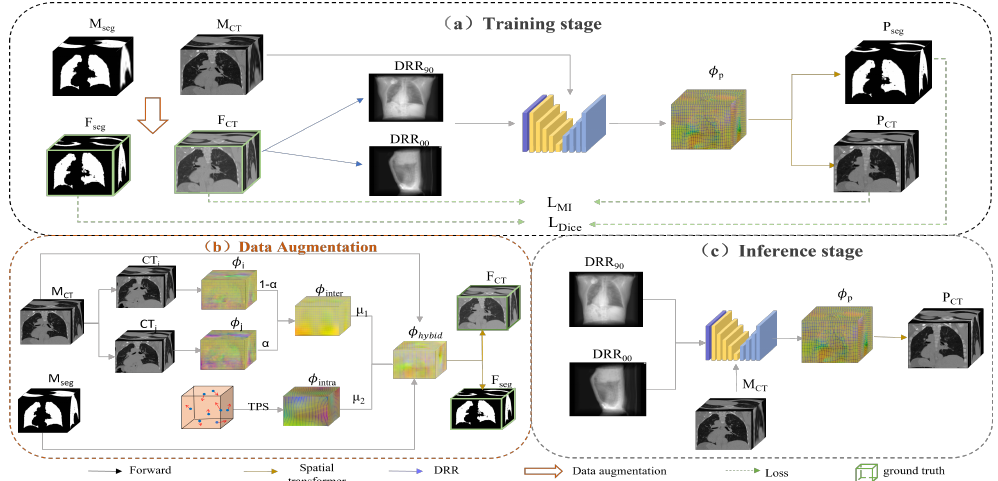
Figure 1. Overview of the proposed method. ( a ) Flowchart of the training phase of the method. First, a large number of CT F CT and segmentation F seg representing each phase are obtained by performing hybrid data augmentation of the moving image M CT and the corresponding segmentation image M seg . Then, the F CT images are projected to obtain the 2D DRR 90 and DRR 00 . After that, they are fed into the registration network with the moving image M CT to obtain the predicted deformation field φ p . Finally, the moving image M CT and the moving segmentation map M seg are transformed to obtain the corresponding predicted images, P CT and P seg . ( b ) The process of hybrid data augmentation. The deformation field φ inter is first obtained by inter-phase registration using traditional image registration. The small deformation φ intra is simulated by TPS interpolation. The hybrid deformation field φ hybrid is obtained by summing with random weights for data augmentation. ( c ) Inference stage. The 2D projection and moving images are directly input to the trained network to get the prediction φ p , and then the registration can be completed by